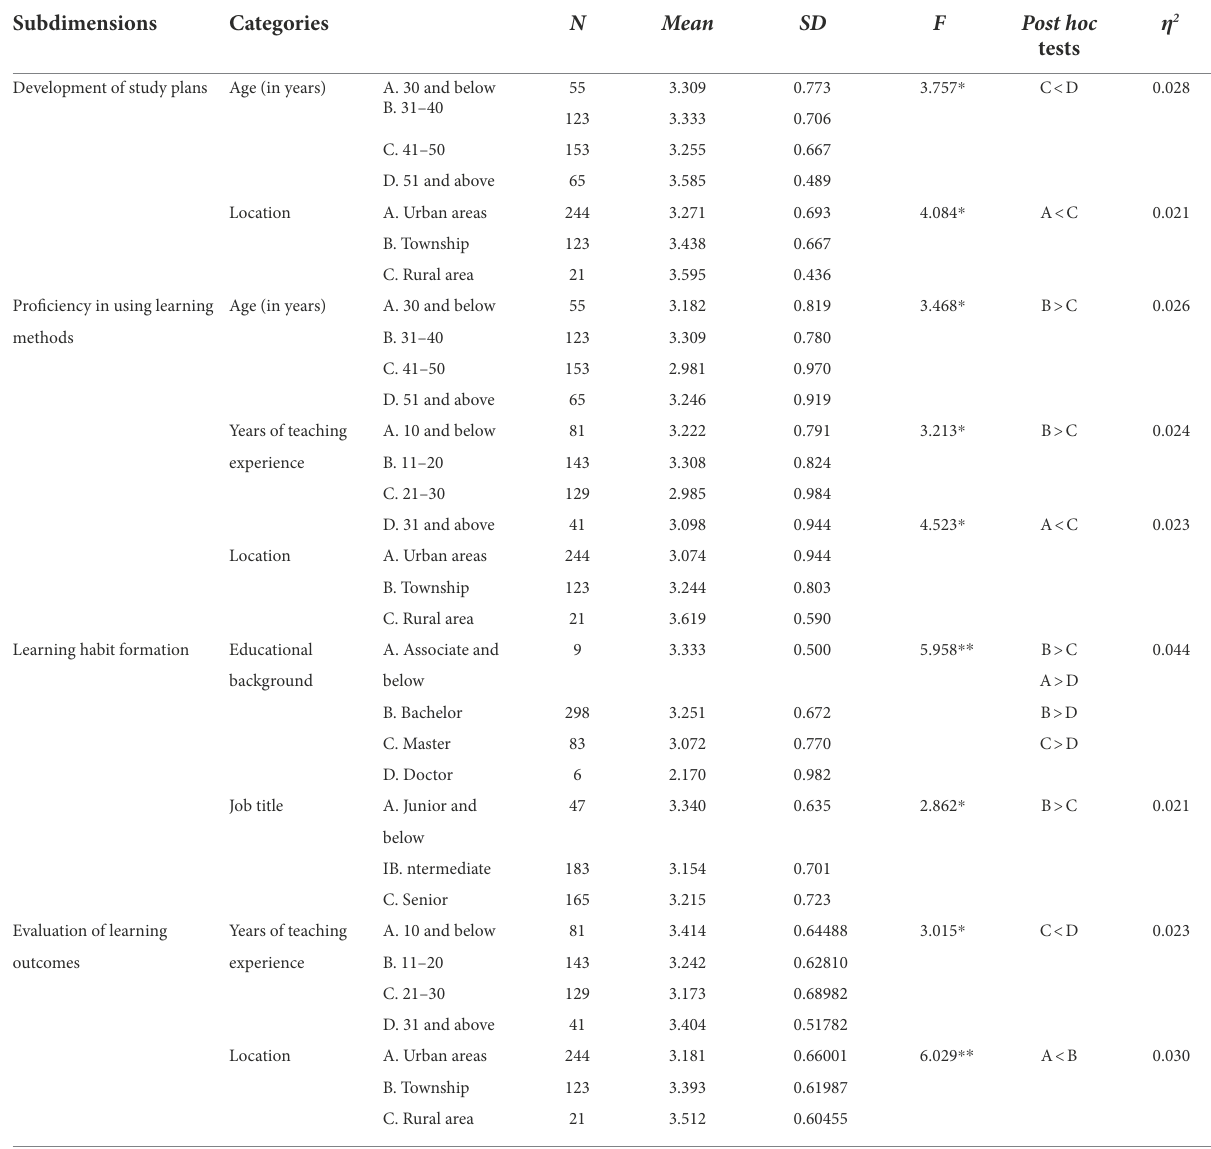
TABLE 6 One-way analysis of variance for teachers’ autonomous learning capacity by